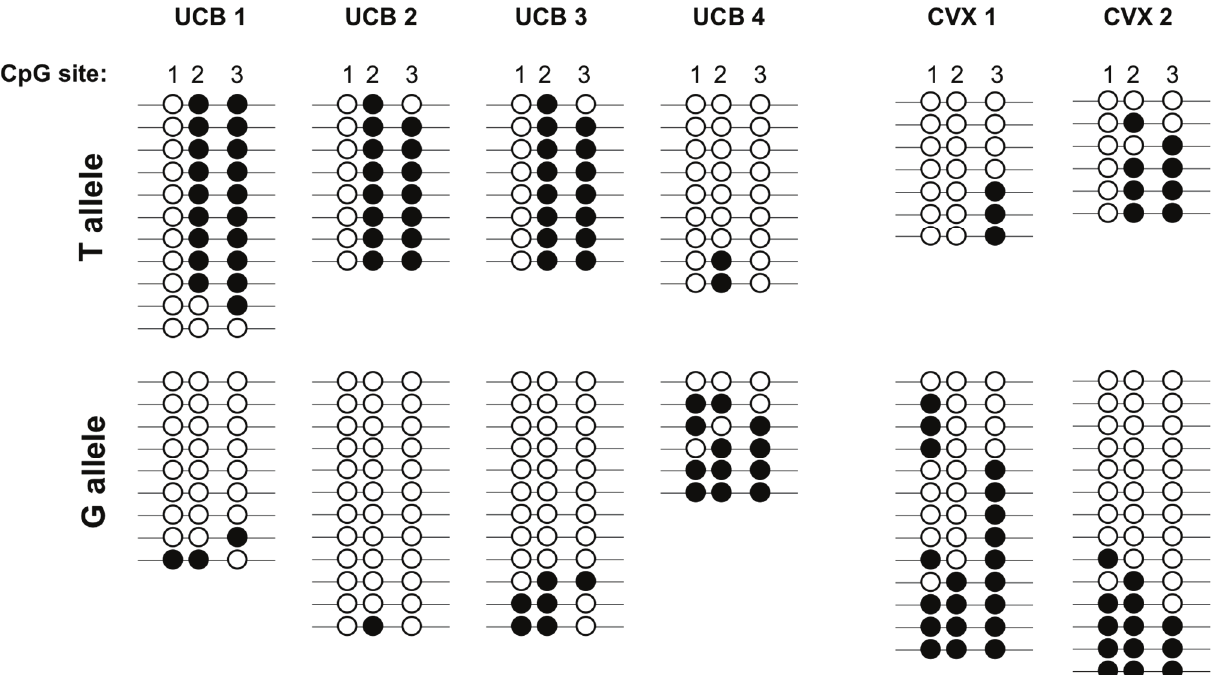
Figure 3. The variant allele lacks methylation at CpG position 1 of the IGF2 DMR. Bisulfite sequencing of cloned alleles for four umbilical cord blood DNA specimens (UCB1-UCB4) and two cervical biopsy specimens (CVX1-CVX2) from individuals carrying the variant allele. Each line represents a given clone and each circle represents one of the CpG dinucleotides within the IGF2 DMR. Filled circles indicate that the cytosine was methylated and the unfilled circles indicate that the cytosine was unmethylated within that clone. The data indicate that the variant T allele exhibits a lack of methylation at the first CpG site within the IGF2